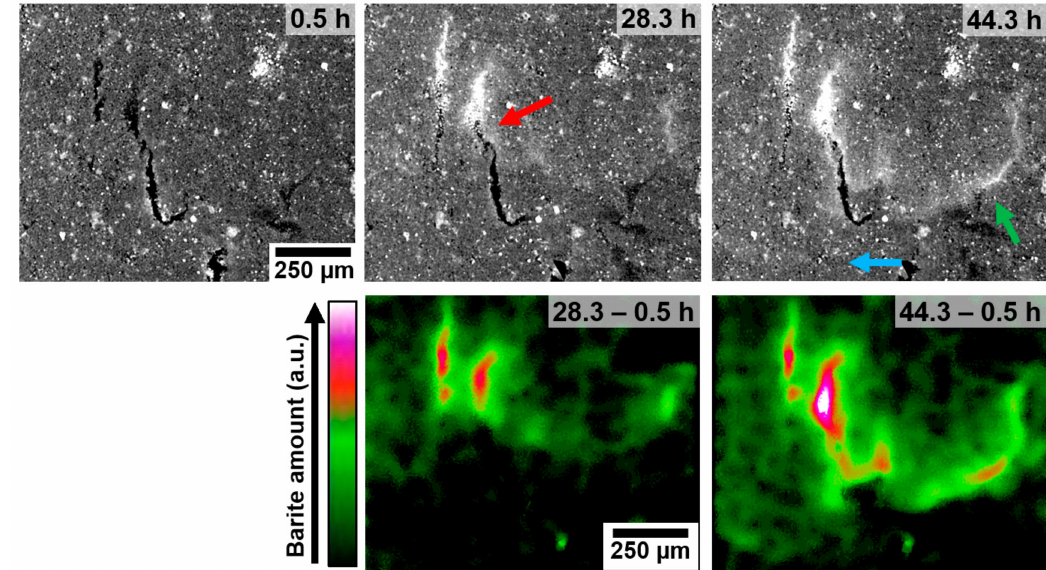
Figure 3. Virtual CT cross-sections parallel to the growth direction at 0.5, 28.3, and 44.3 h, crystal-free fractures are black, and barite is identified in progressively brighter pixels. To highlight the moving growth front the images at times 28.3 and 44.3 h were subtracted by the image at frame time 0.5 h, whereby hotter colours identify regions with a higher volume fraction of barite. Red arrow: Clogging point in the wide fracture; Green arrow: Clogging region at a fracture that blocks the growth direction; Blue arrow: Growth front in the nanoporous matrix.